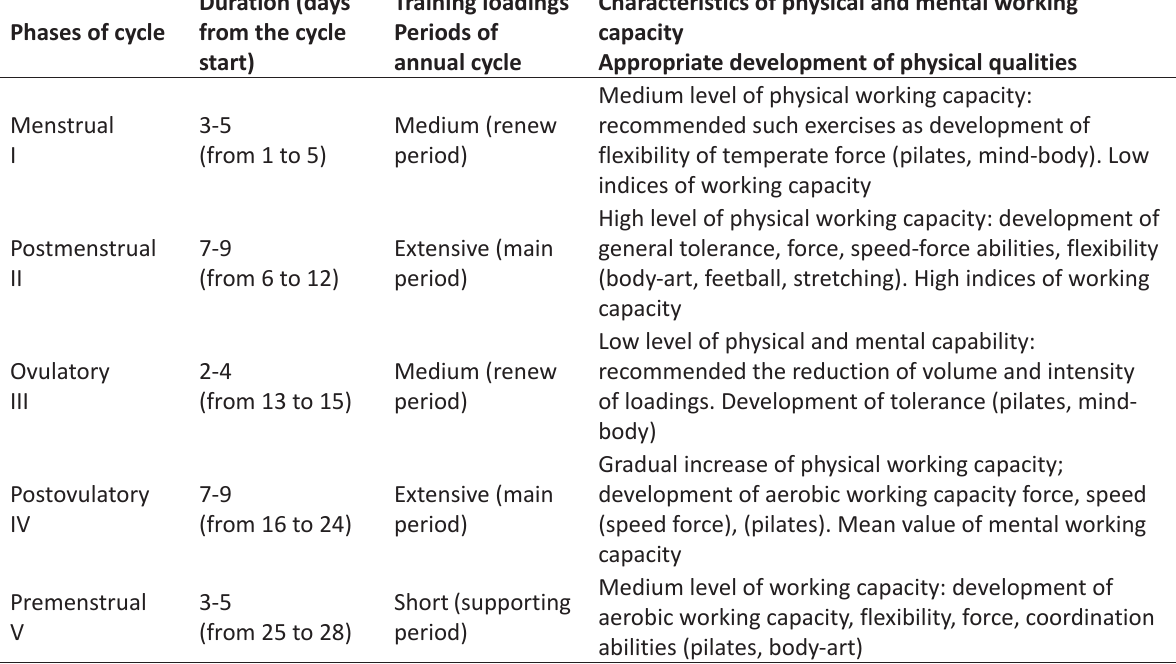
Table 1. The general structure of the loads according to the periods of annual cycle according to the phases of the ovarian-menstrual